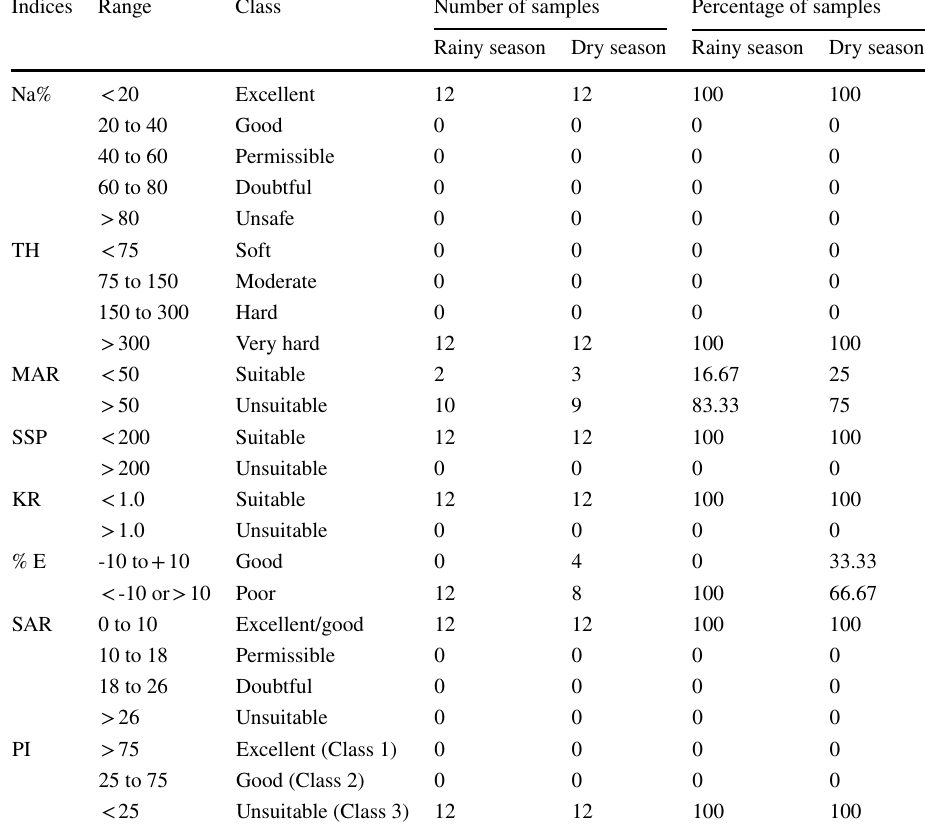
surface water from River Mamu